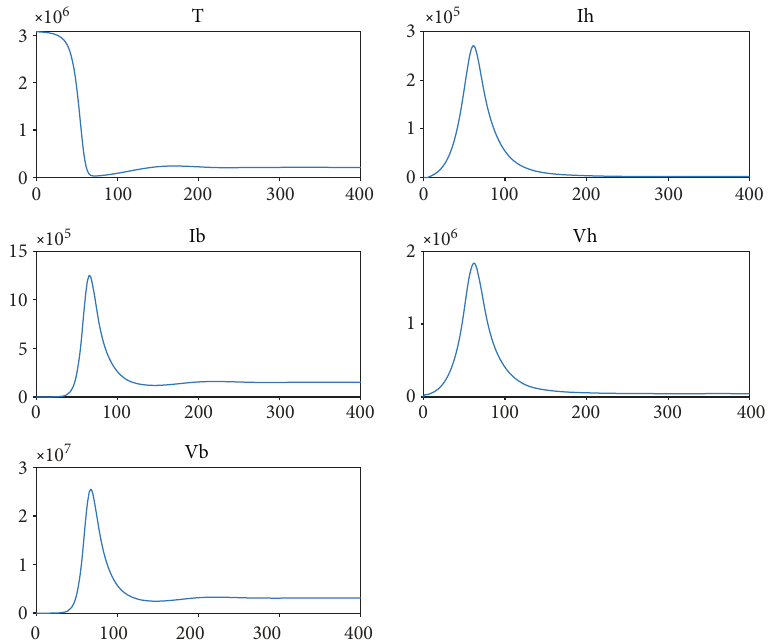
= τ = 5days . Parameter values are as shown in Table 1. Horizontal 1 2